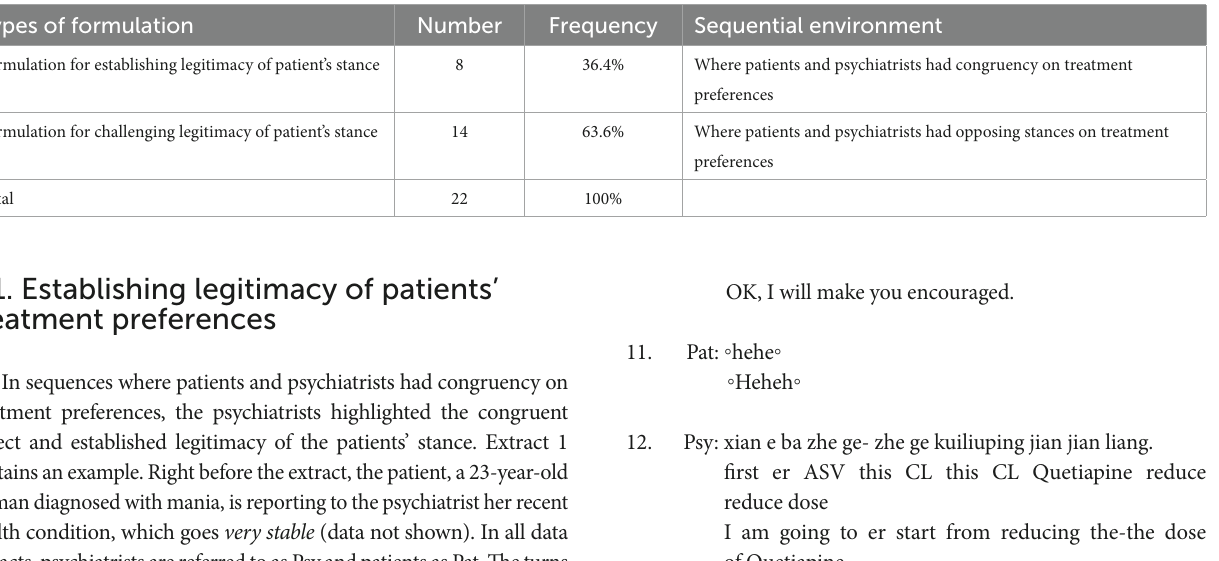
TABLE 1 Description of the two types of